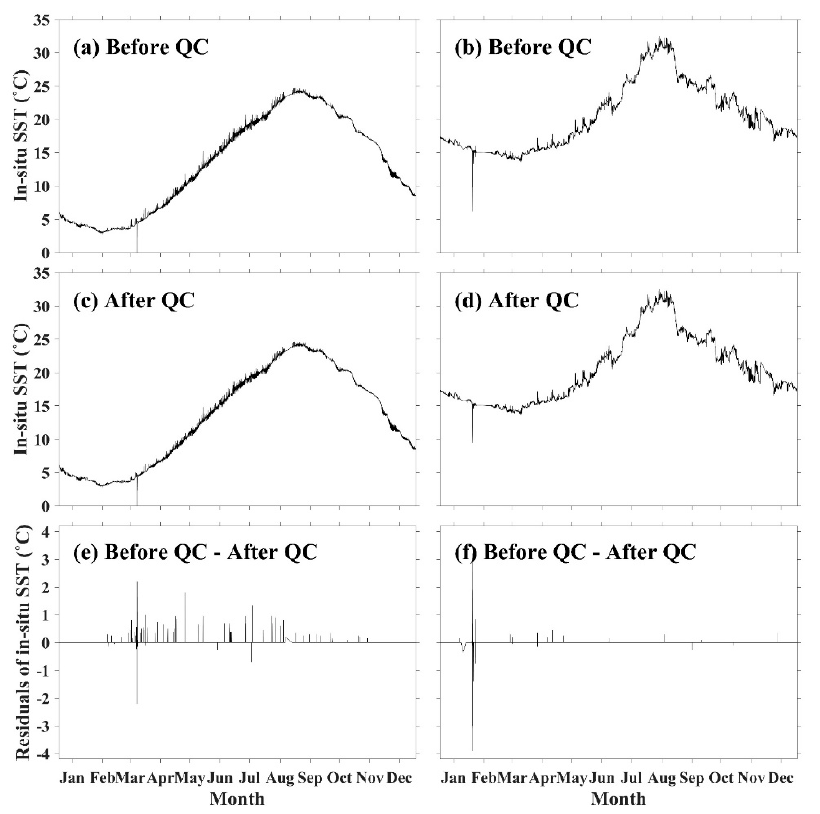
Figure 5. Examples of time series of in-situ sea temperature (°C) observed by KMA buoys ( a , b ) before and ( c , d ) after QC procedure to remove abnormal temperatures and ( e , f ) the comparison of residual (before QC procedure and after QC procedure).